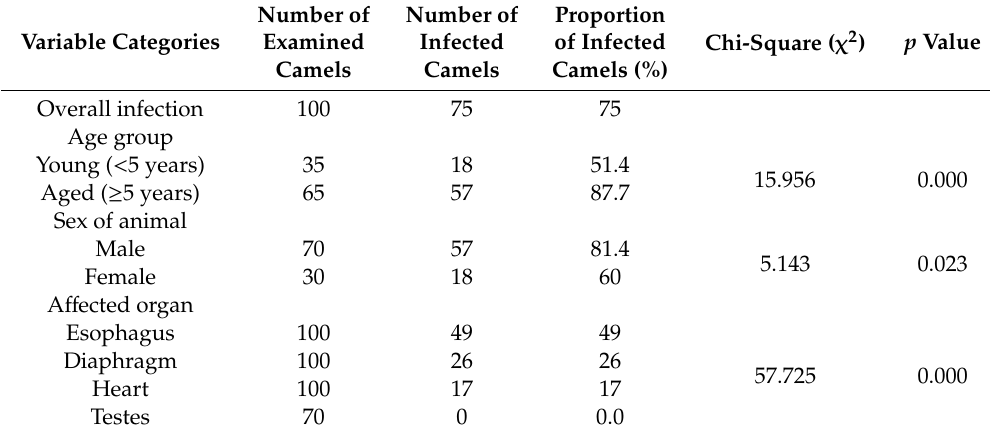
Table 1. Prevalence of Sarcocystis infection in camels slaughtered at Aswan